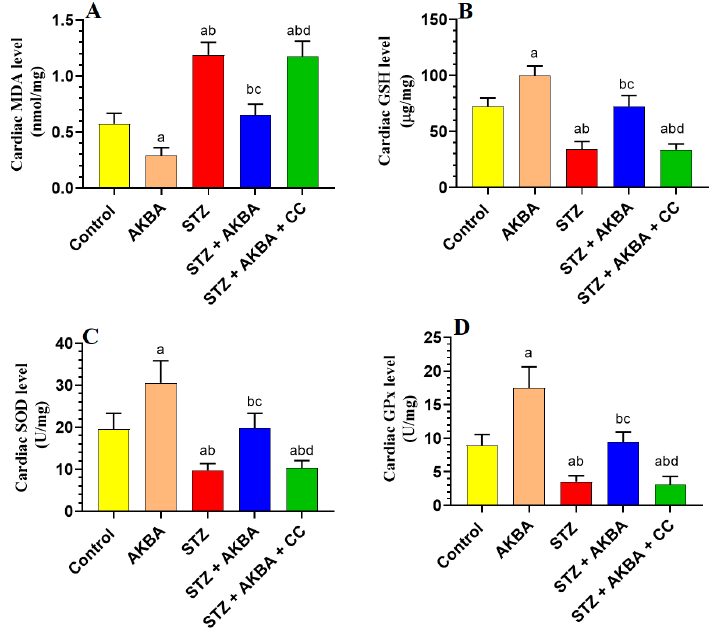
Figure 6. Total levels of malondialdehyde (MDA) ( A ), glutathione (GSH) ( B ), superoxide dismutase (SOD) ( C ), and glutathione peroxidase (GPx) ( D ) in the left ventricles (LVs) of all rat groups. Data were analyzed with one-way ANOVA followed by Tukey’s test. Values are presented as mean ± SD (n = 8/group). Data were considered significantly different at p < 0.5. a: significantly different as compared to control rats; b: significantly different as compared to AKBA-treated rats; c: significantly different as compared to STZ-diabetic rats; d: significantly different as compared to STZ + AKBA- treated rats. CC–compound C (a selective AMPK inhibitor).